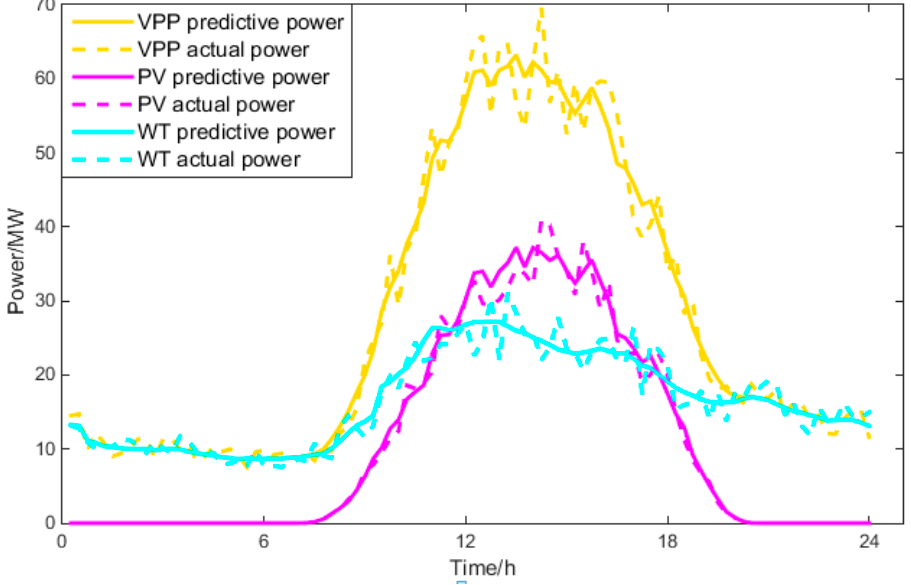
Figure 5. The output curves and probabilities of typical scenarios of all seasons. ( a ) The output of typical scenarios in spring; ( b ) The probabilities of typical scenarios in spring; ( c ) The output of typical scenarios in summer; ( d ) The output of typical scenarios in autumn; ( e ) The output of typical scenarios in autumn; ( f ) The probabilities of typical scenarios in autumn; ( g ) The output of typical scenarios in winter; ( h ) The output of typical scenarios in winter.